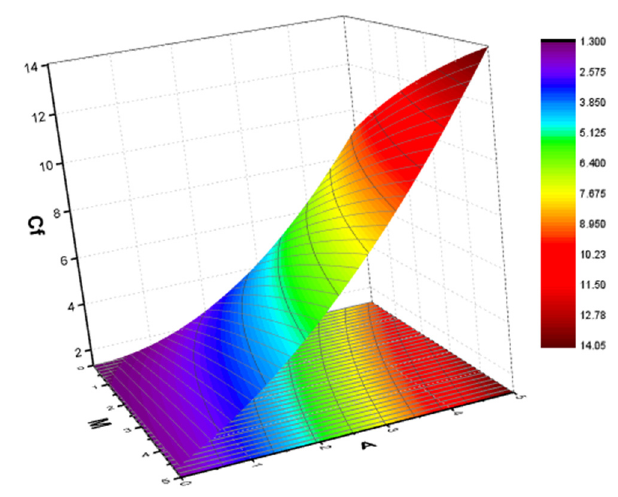
Figure 22. Effect of M and A on Cf x .